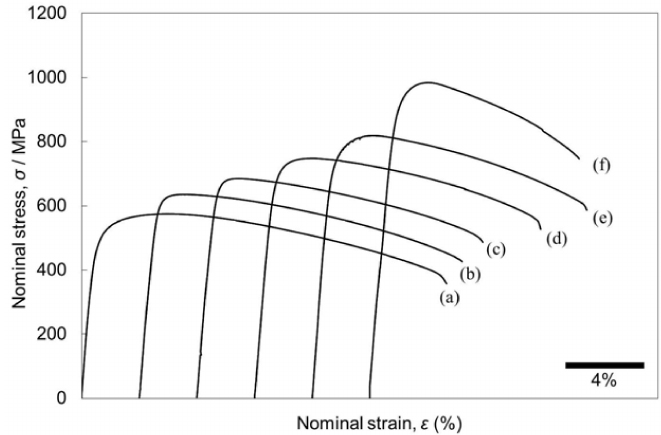
Figure 6. Stress-strain curves of the Zr–1Mo alloy specimens: ( a ) before cold swaging and after cold